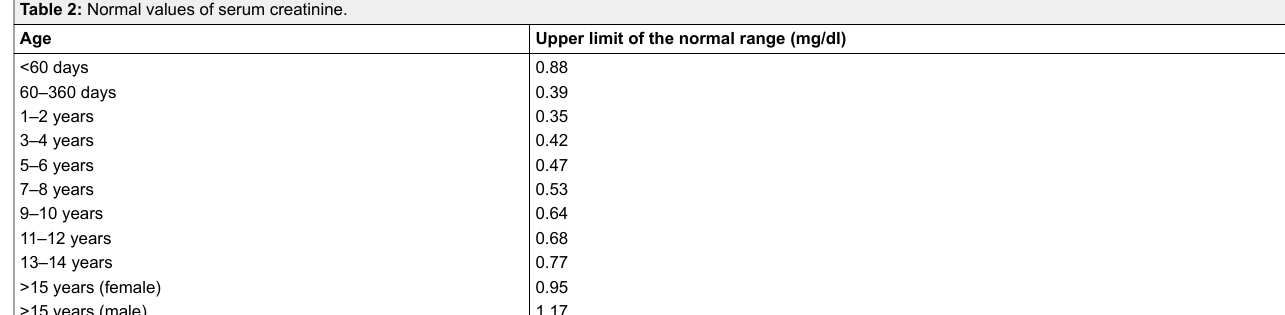
Table 2: Normal values of serum creatinine. Age Upper limit of the normal range